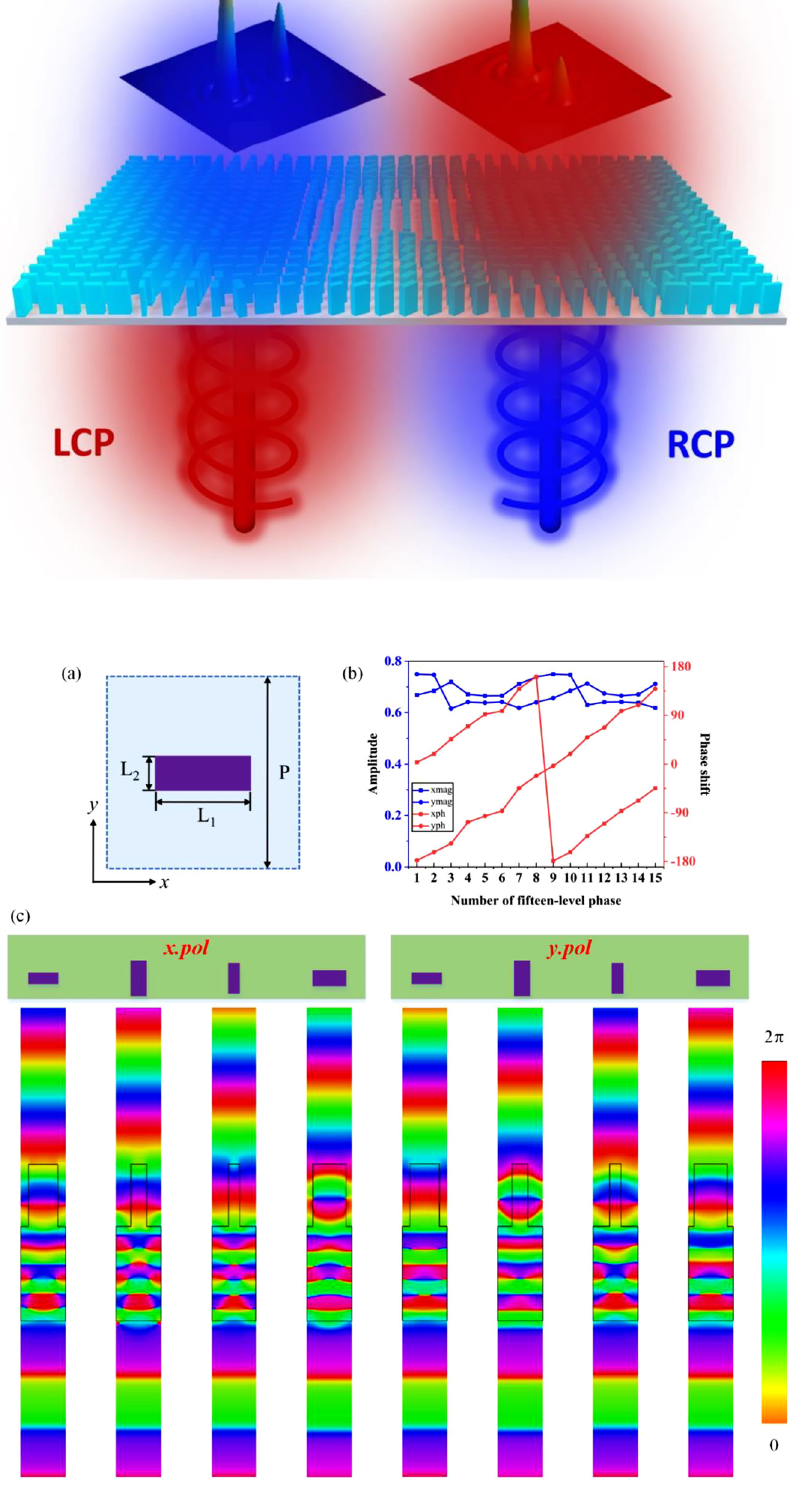
Figure 2: Characterization of the designed meta-atoms. (a) Schematic of the rectangular-shape silicon pillar. (b) Simulated